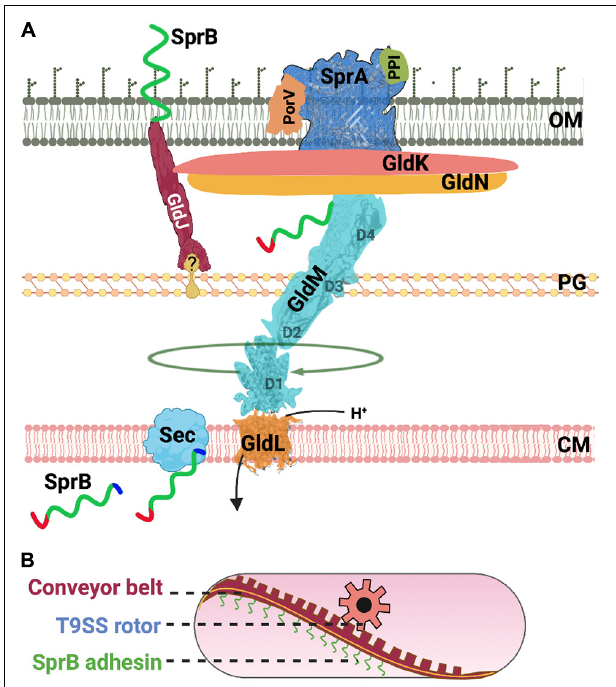
FIGURE 2 | Structure and function of the T9SS. (A) A cartoon of the nuts and bolts of the T9SS motor that drives protein secretion and gliding motility. T9SS substrates (SprB shown as an example) are transported to the periplasm via the Sec transport pathway. The CTD of T9SS substrates is cleaved during transport. A recent model suggests that the proton channel GldL powers the rotation of T9SS. (B) A cartoon of the molecular rack and pinion machinery that drives gliding motility. A model based on recent data suggests that the rotary T9SS pinion drives a cell-surface conveyor belt (rack). Cell-surface adhesins such as SprB are secreted by T9SS and are loaded onto the conveyor belt. Interaction of SprB with an external substratum results in screw-like gliding motility of the bacterial